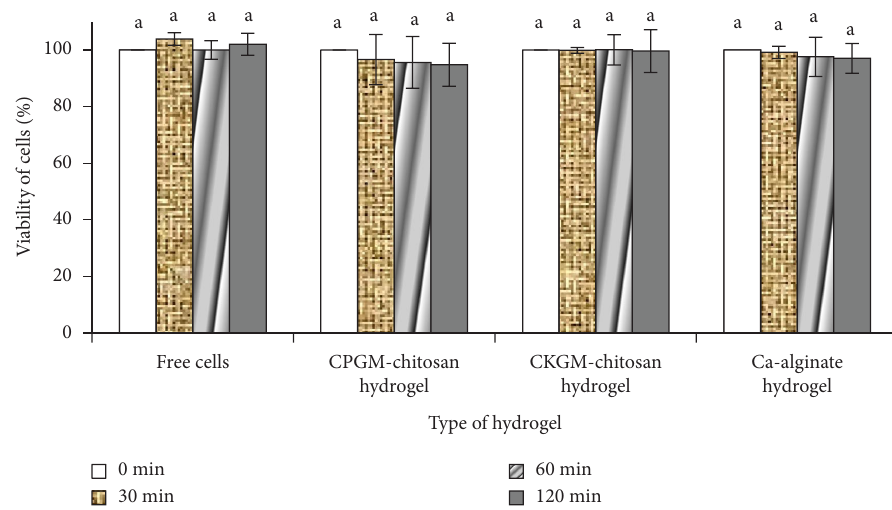
Figure 4: L. acidophilus FNCC 0051 viability during exposure to gastric juice for 120min. Key: a, p < 0 . 05, CPGM: carboxymethyl porang glucomannan, and CKGM: carboxymethyl konjac